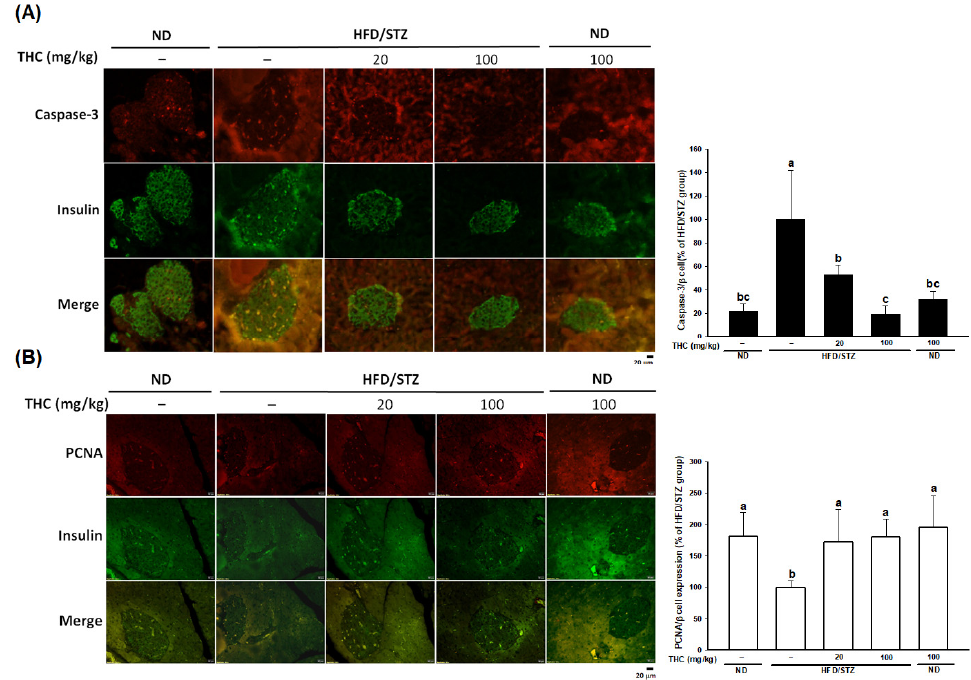
Figure 6. Effect of THC on β -cell apoptosis and proliferation in HFD/STZ treated mice. ( A ) Apoptosis of β -cell was analyzed by double immunofluorescence staining with caspase-3 (red) and insulin (green). ( B ) Proliferative β -cells were analyzed by double immunofluorescence staining with PCNA (red) and insulin (green). Quantification was performed by ImageJ. Data are expressed as mean ± SEM ( n = 6). Statistical differences ( p < 0.05) between groups were evaluated by one-way ANOVA with Tukey’s post-hoc test and were labeled as different letters (a, b, and c).